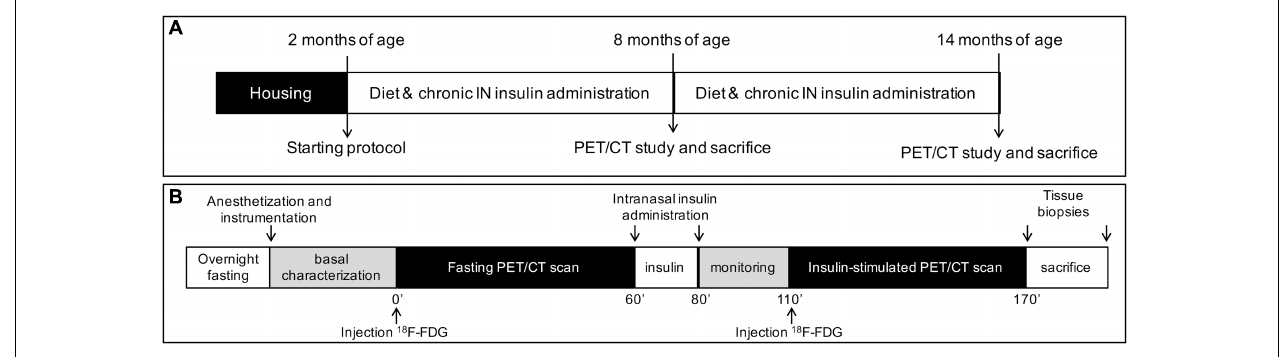
FIGURE 1 | The panels show the study design (A) , and PET-CT scanning session (B) . ND and HFD were tested in controls and 3 × Tg mice, whereas chronic intranasal insulin therapy (INI) was tested in an additional group of 3 × Tg-HFD